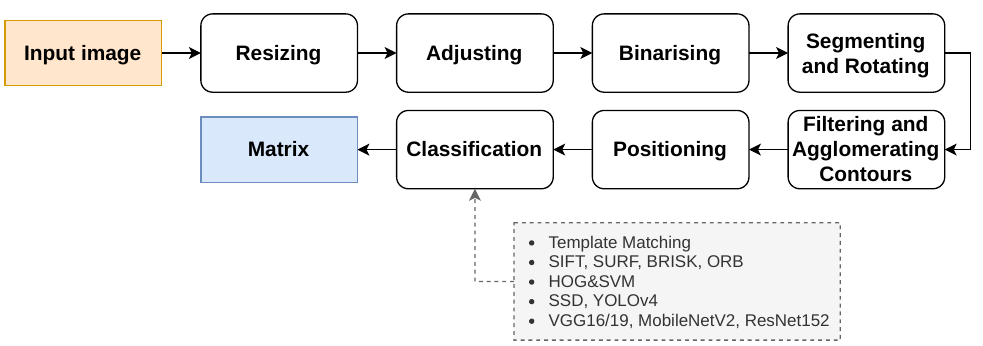
Figure 2. Block diagram of the image processing